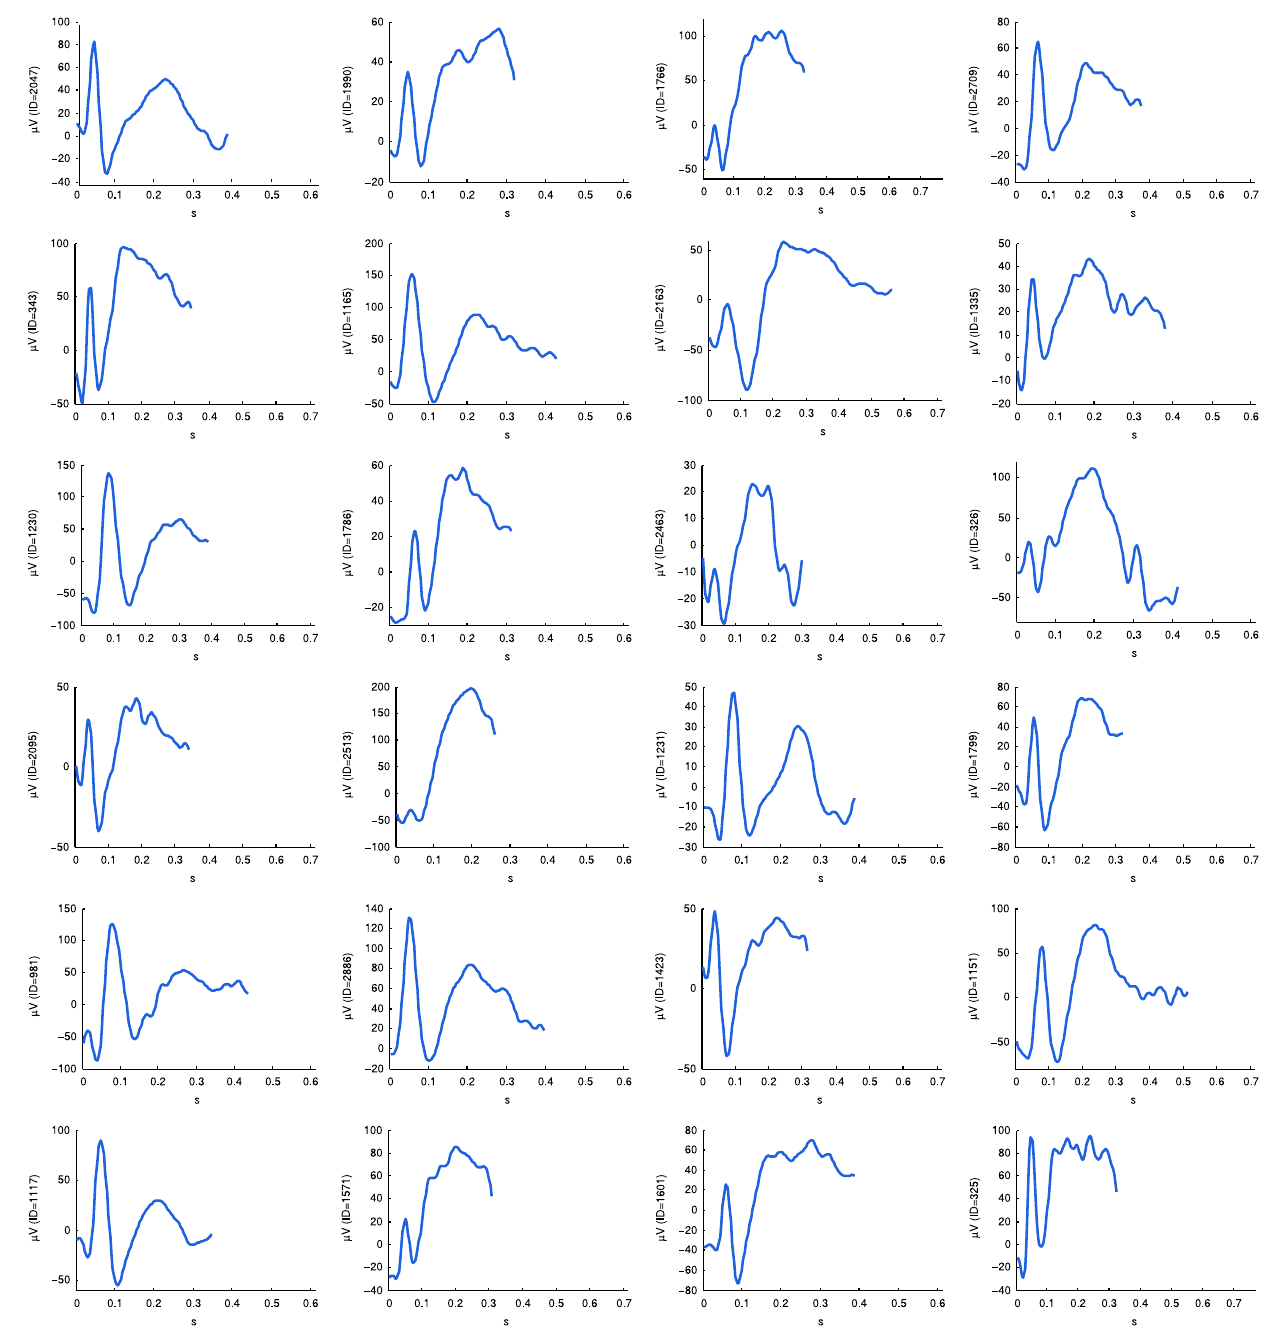
Figure 1. Sample template waveforms collected from a training dataset. To find inter-ictal epileptiform activity in new unseen EEGs, each template searches for matching waveforms with high correlations to themselves. Thereafter, individual template detections are combined to form ‘‘IED nominations’’ which are then presented to the reviewer in decreasing order of likelihood.